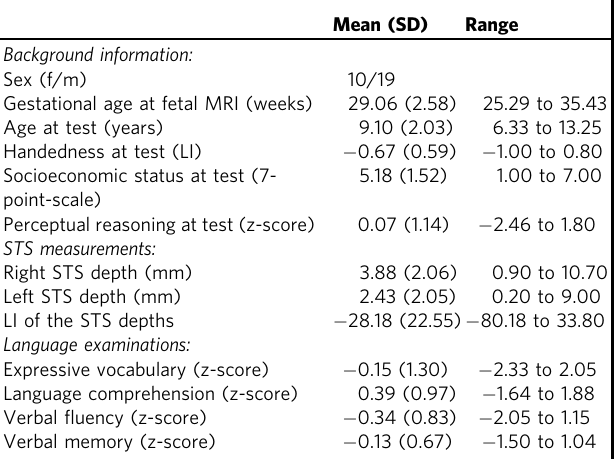
Table 1 Study group with visible fetal STS ( n =